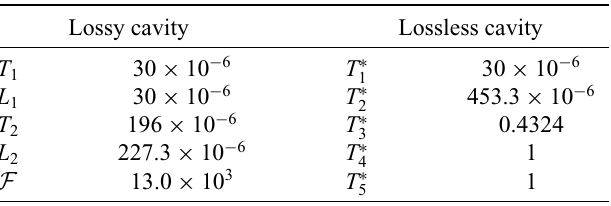
TABLE I. Properties of the experimentally realized, lossy cav- ity [27,138], as well as the equivalent lossless cavity, with values given with a relative accuracy of 10 − 4 . of T ∗ i